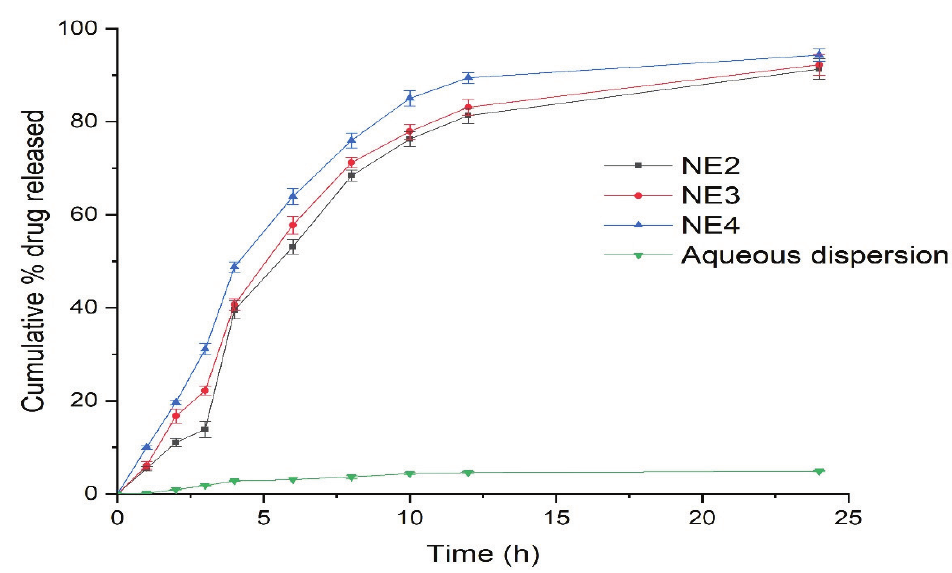
Figure 3. In-vitro drug release study comparing retinyl palmitate (RT)-loaded nanoemulsions to the aqueous dispersion of pure RT using the dialysis bag technique.